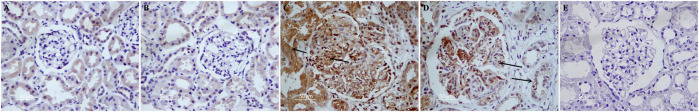
Localization of Ang II in kidneys from the four groups of mice. Immunohistochemistry was performed as described in the Materials and Methods. (A) Control group. In the control group, Ang II is scattered in the cytoplasm of renal tubular epithelial cells, and the expression of glomerulus is very little. (B) Ang-(1–7) group. (C) LPS group. Ang II positive results are brown particles. The black arrows indicate positive expression. (D) LPS + Ang-(1–7) group. The black arrows indicate positive expression. The expression intensity and range of Ang II were significantly reduced compared with the LPS group. (E) Negative control group. Bars in A–E = 50 µm.